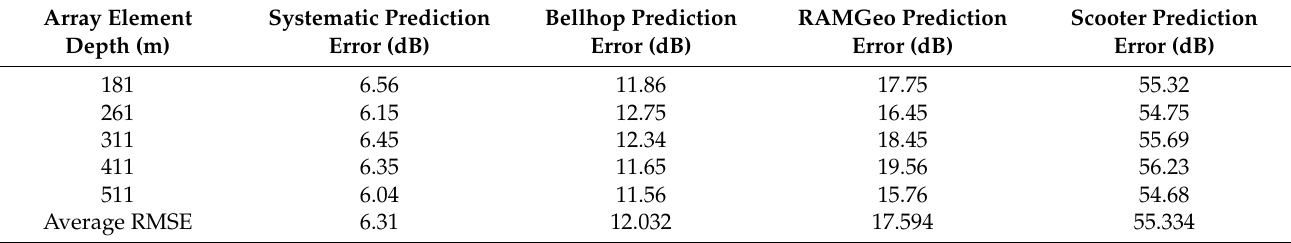
Table 6. RMSE error comparison (360 Hz).